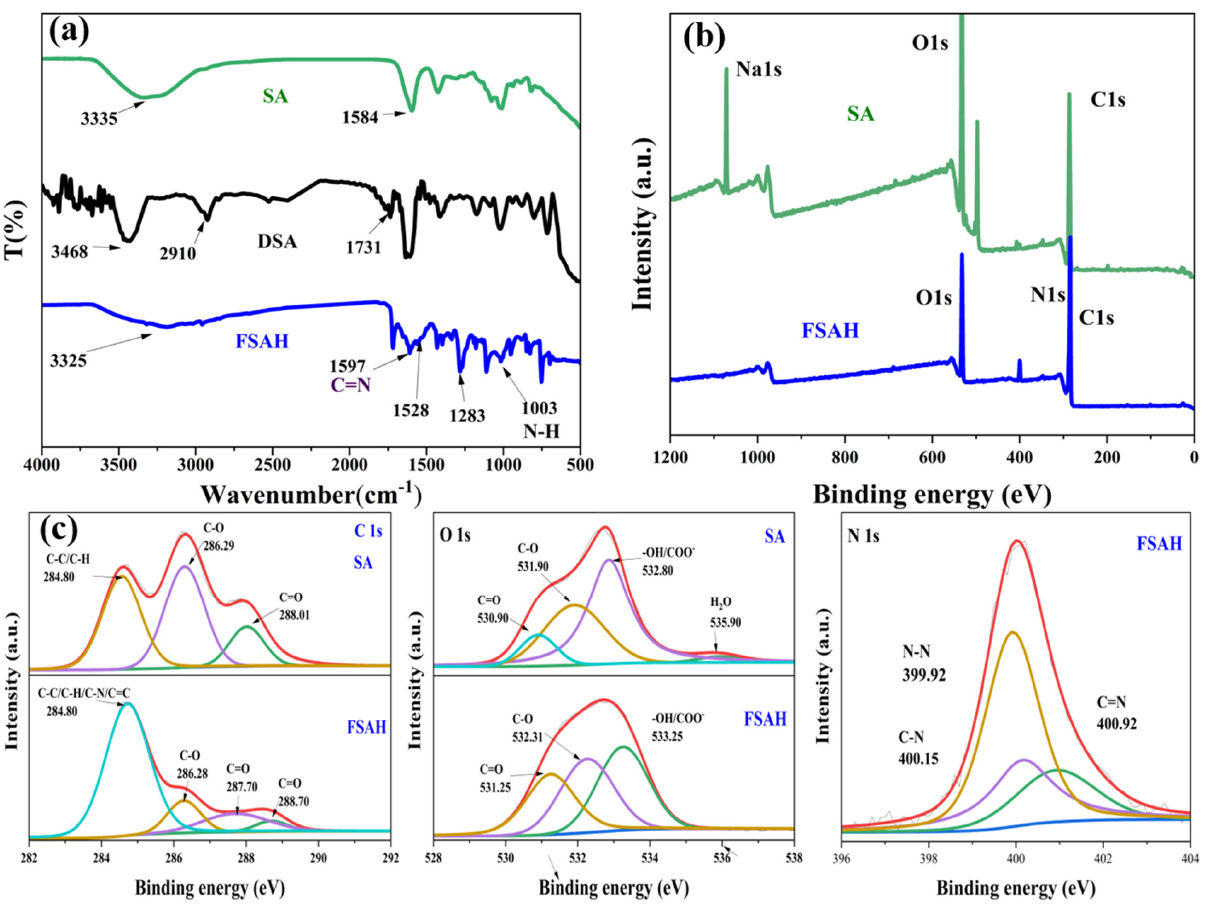
Figure 2. ( a ) FT ‒ IR spectra of SA, DSA, and FSAH. ( b ) The XPS spectra of SA and FSAH. ( c ) C 1s, O 1s, and N 1s spectra of SA and FSAH.